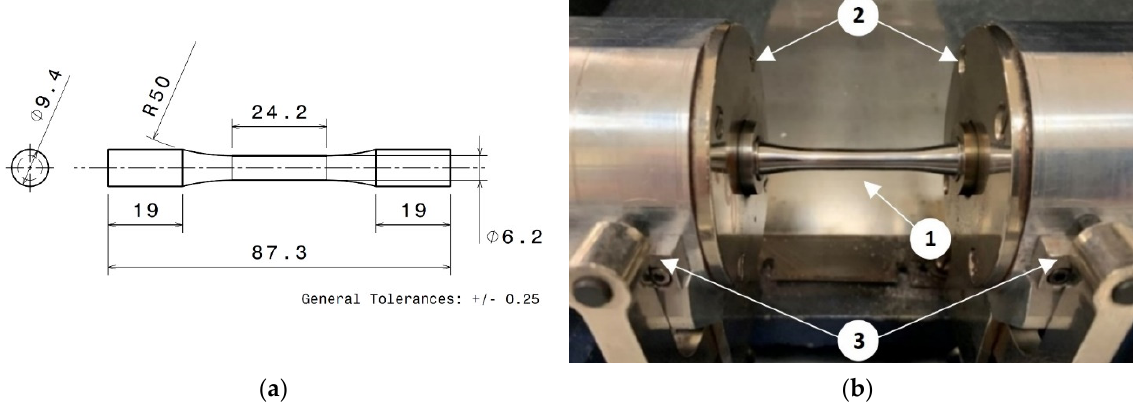
Figure 2. Experimental setup. ( a ) Fatigue test specimen design, dimensions in mm. ( b ) Experimental assembly: (1) polished specimen, (2) bearing shafts, (3) load-bearing system.